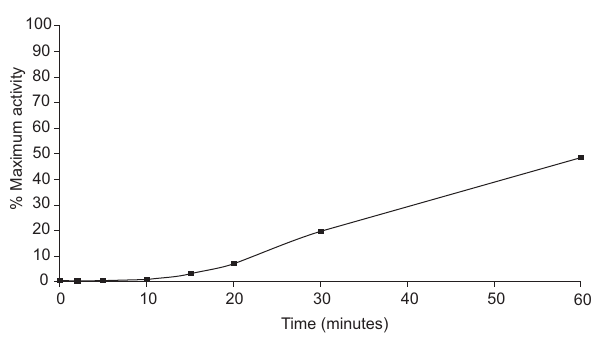
Figure 2. Kinetic analysis of plasma complement activity of the fresh- water turtle P. geoffroanus . SRBCs were incubated in an equal vol- ume of 100% of turtle plasma for various amounts of time. The samples were centrifuged and the optical densities of the superna- tants were measured at 540 nm. Each sample was analyzed in qua- druplicate and the results represent the mean ± standard deviations.